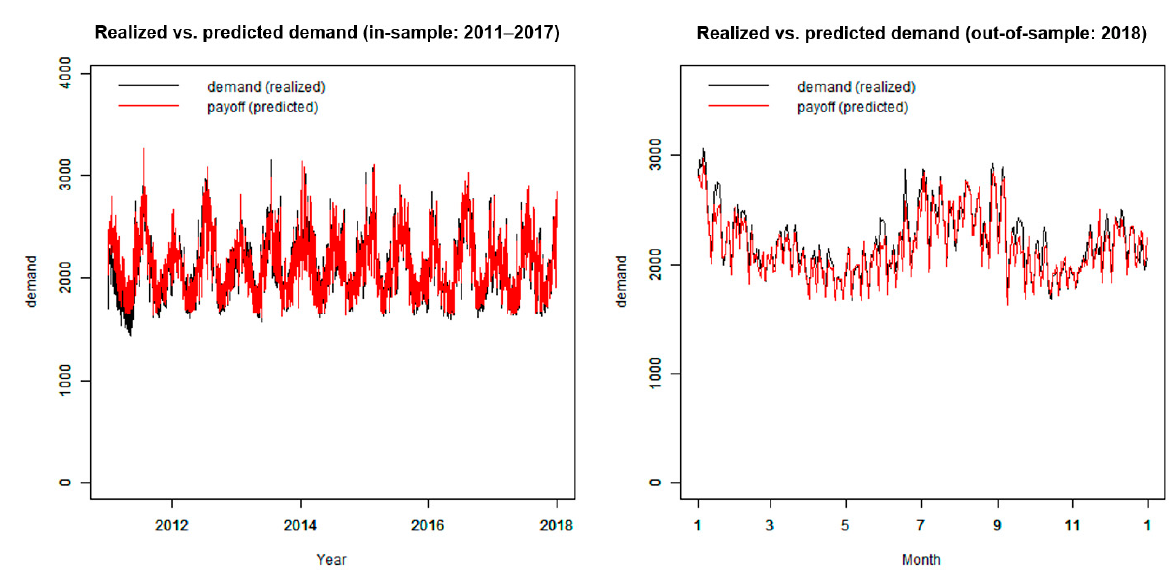
Figure A5. Comparison of realized and predicted values for the demand model.